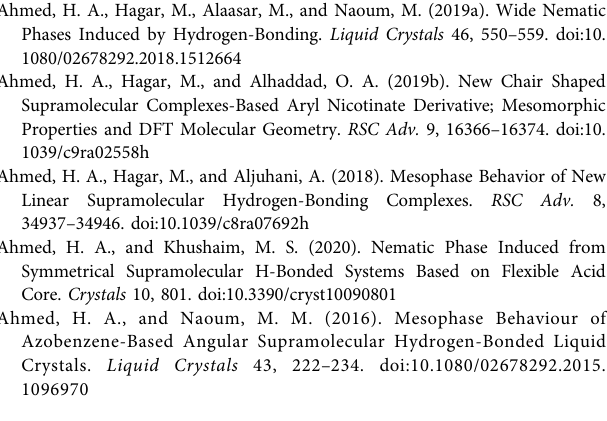
Frontiers in Chemistry |